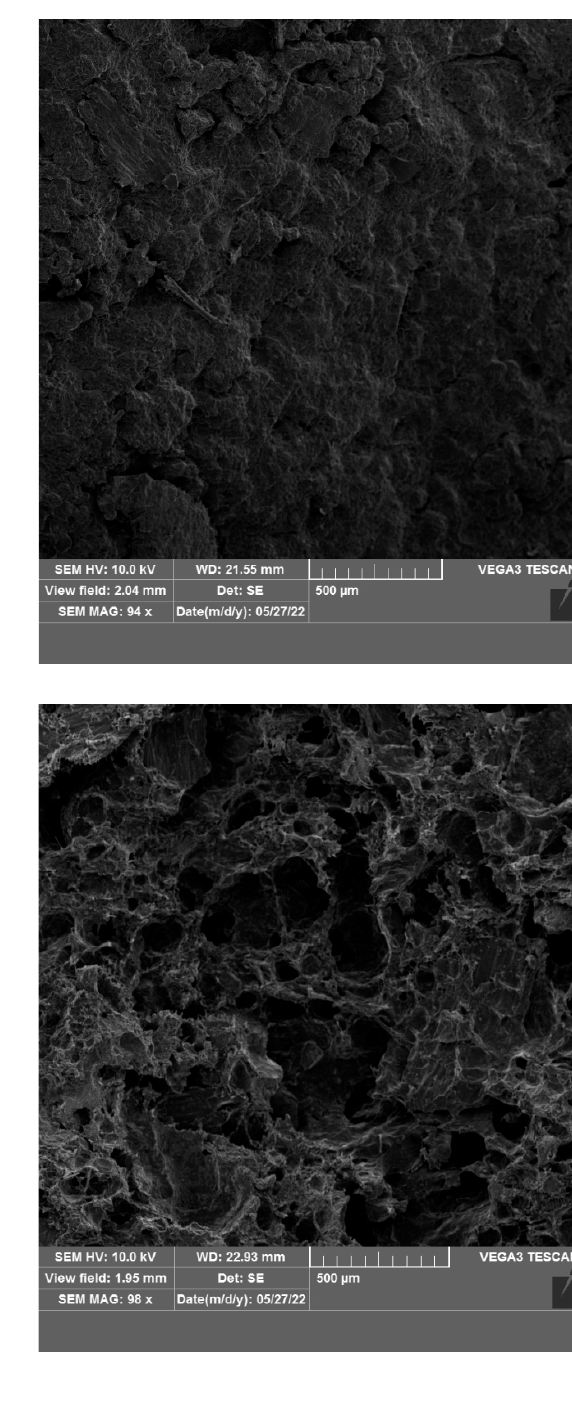
Figure 4. ( a ) The surface of the snack S3; ( b ) the cross-section of the snack S3.